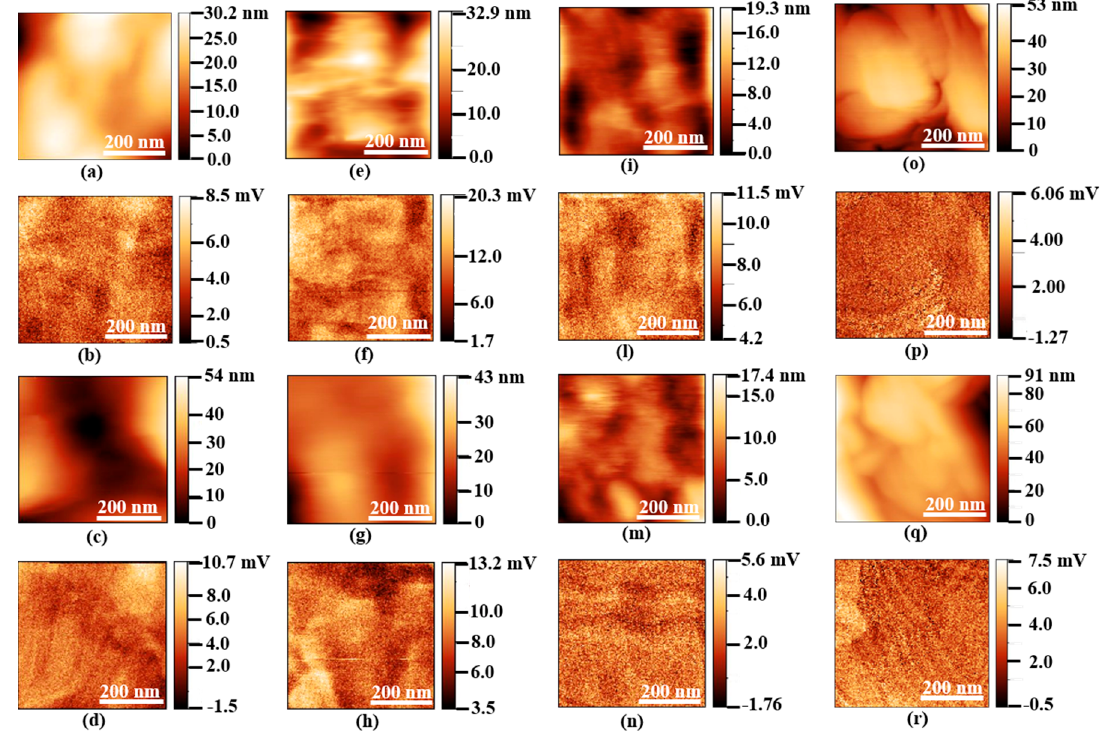
Figure 7. Morphological maps and vertical (out-of-plane) PFM signals at V ac = 10 V and at 15 kHz for Neat-PVDF ( a , b ), for M1-HS1 ( c , d ), for M1-HS2 ( e , f ), for M1-HS3 ( g , h ), for M1-HS4 ( i , l ), for M1-HS5 ( m , n ), for M2-HS1-GNP ( o , p ), and for M2-HS1-ZnO ( q , r ).